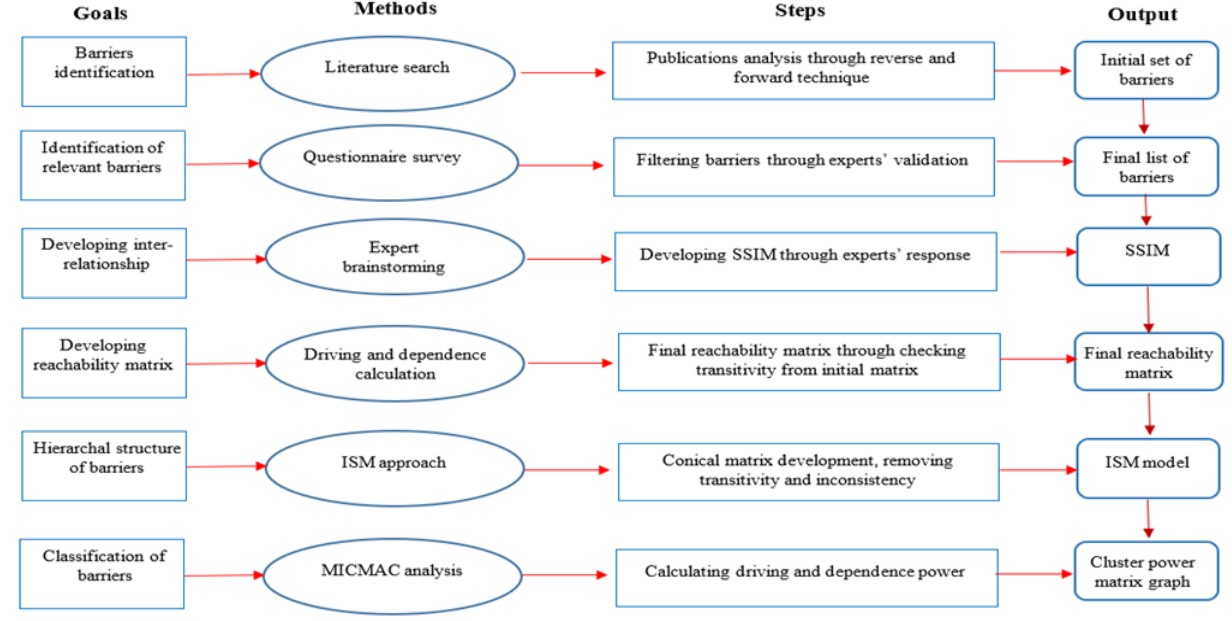
Figure 1. Detailed approach/methodology towards identifying green innovation